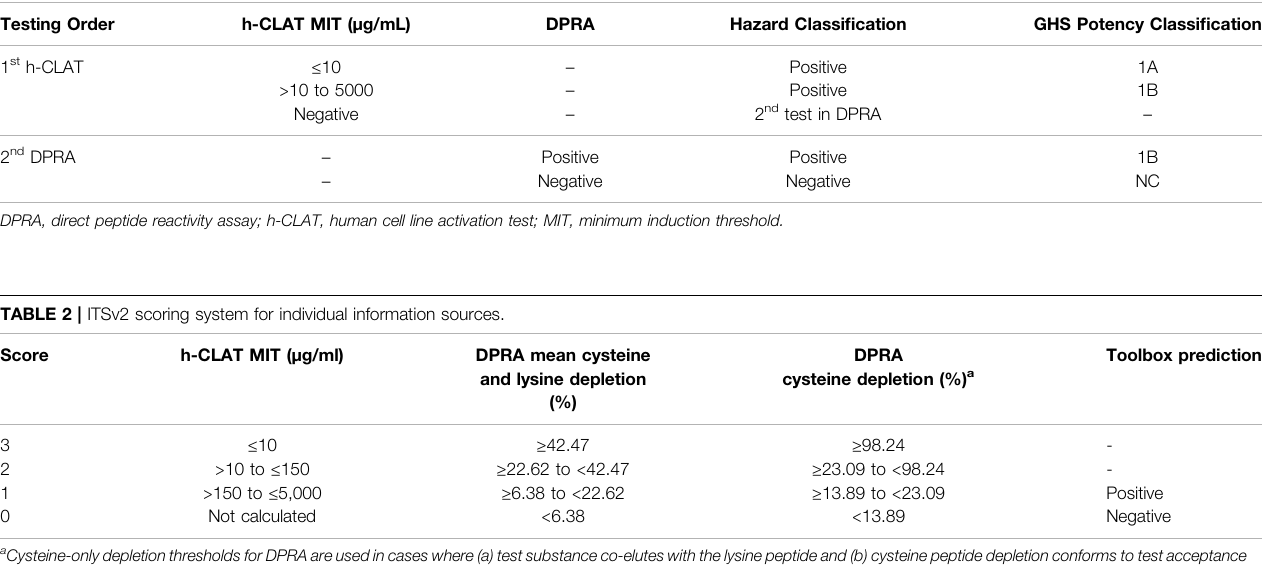
TABLE 1 | The KE 3/1 sequential testing strategy (STS).